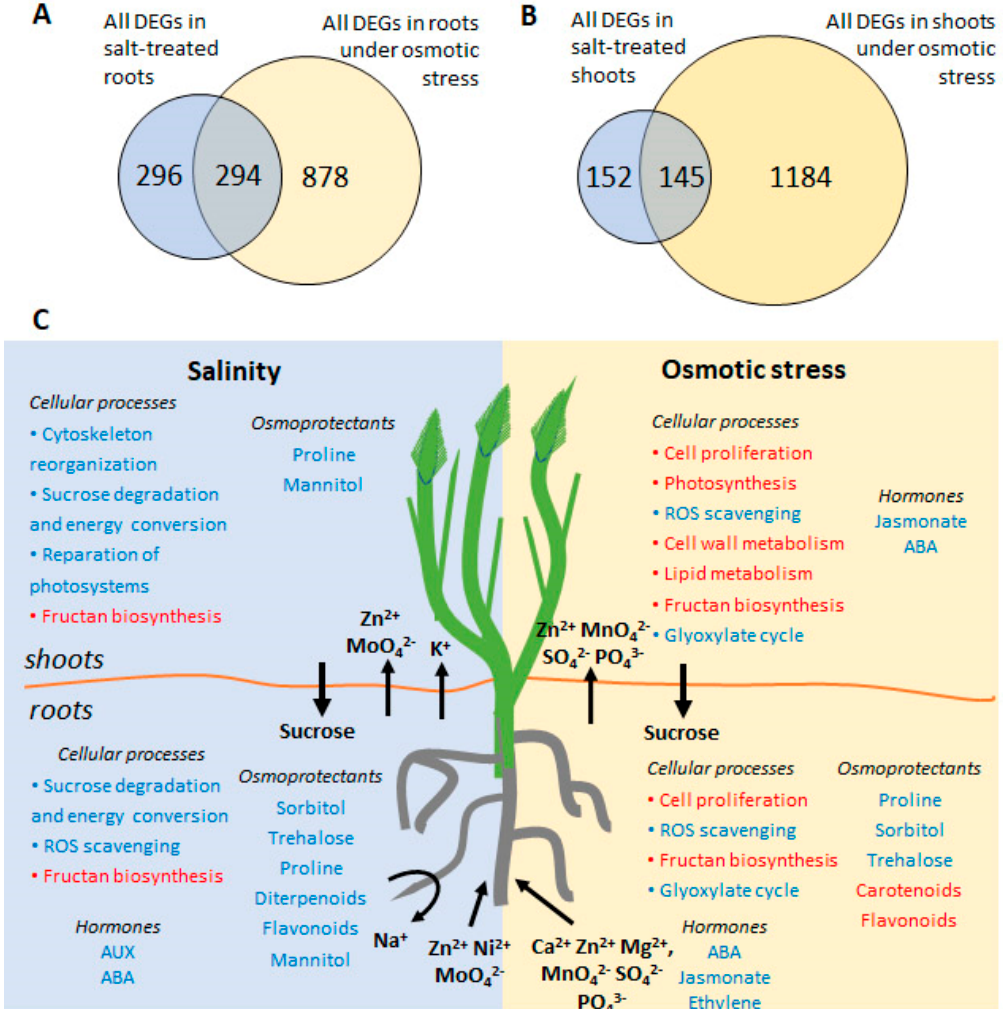
Figure 7. ( A , B ) Venn diagram showing the numbers of common and stress-specific differentially expressed genes (DEG) in roots ( A ) and shoots ( B ) after osmotic (15% PEG6000) and salt (300 mM NaCl) stresses. (C) A schematic overview of the main processes occurred during salinity and osmotic stress in H. marinum . Activated processes are highlighted in blue, inhibited processes are highlighted in red. Arrows indicate directions of mineral, phytohormone, and sugar redistribution between roots and shoots upon stress treatment.